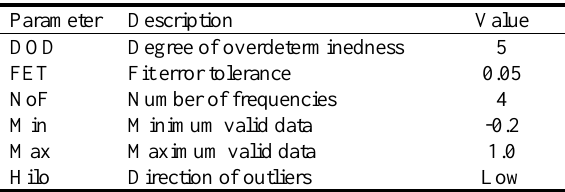
Table 2. The parameter settings of HANTS